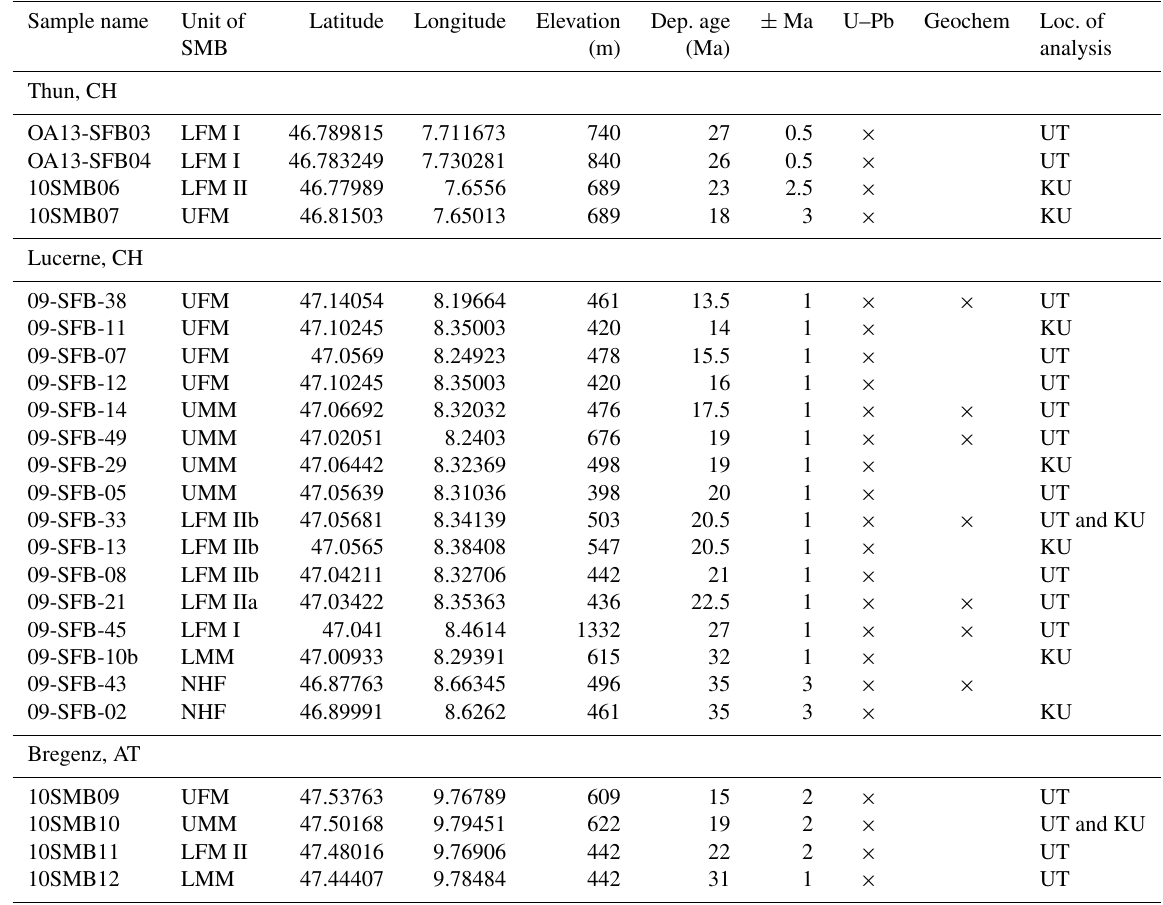
Table 1. Sample information. Depositional age errors are based on the following references: Lucerne Section – Schlunegger et al. (1997a) with modifications using the most recent magnetopolarity timescale of Lourens et al. (2004); Thun Section – Schlunegger et al. (1993, 1996); Bregenz Section – Oberhauser (1994), Kempf et al. (1999), and Schaad et al. (1992). The “ × ” sign in the “U–Pb” and “Geochem” columns indicates that data are available for that sample. The final column indicates whether samples were analyzed at either the University of Kansas (KU) or the University of Texas at Austin (UT). Errors for depositional ages are discussed in further detail in Sect. 3. Corresponding methods are found in Sect. 4. SMB: Swiss Molasse